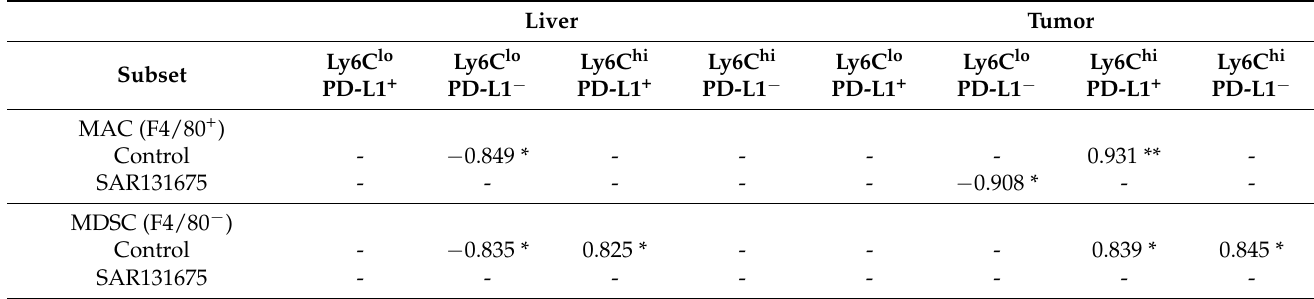
Table 4. Associations for myeloid cell subsets correlations with CD103 + CD8 + T cell subset a . Liver Tumor